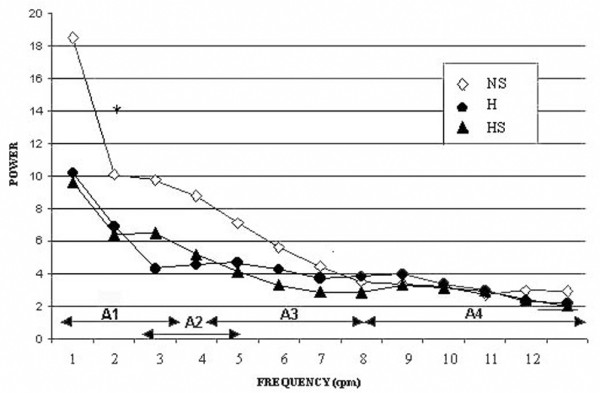
Distribution of vasomotion frequencies during reactive hyperaemia according to sedation. Kolmogorov-Smirnov test: *p < 0.05 NS period versus H and HS periods. cpm, cycles per minute; H period, set of measurements obtained when the patients were sedated by midazolam; HS period, set of measurements obtained when the patients were sedated by midazolam and sufentanil; NS period, set of measurements obtained when the patients were non-sedated.